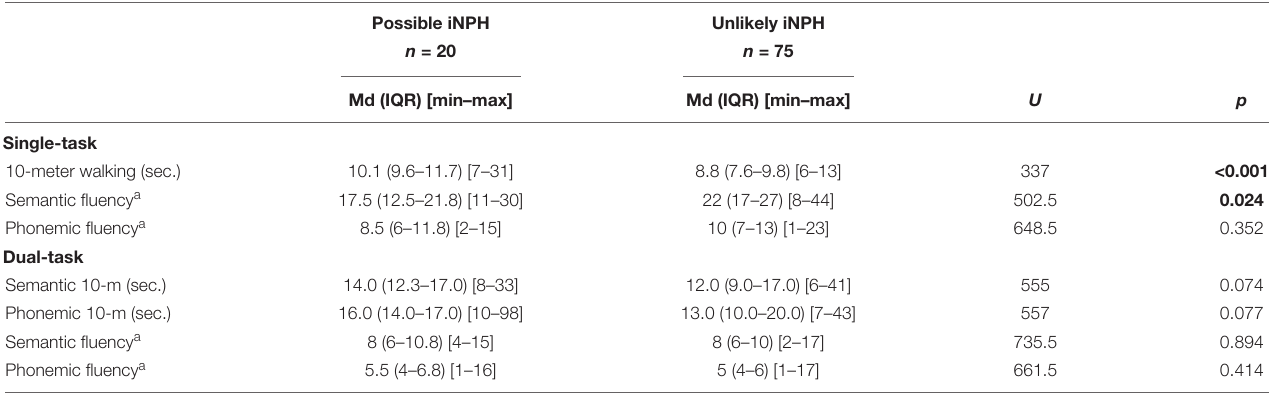
TABLE 3 | Mann-Whitney U -tests of group differences in walking speed and verbal fluency. Possible iNPH Unlikely